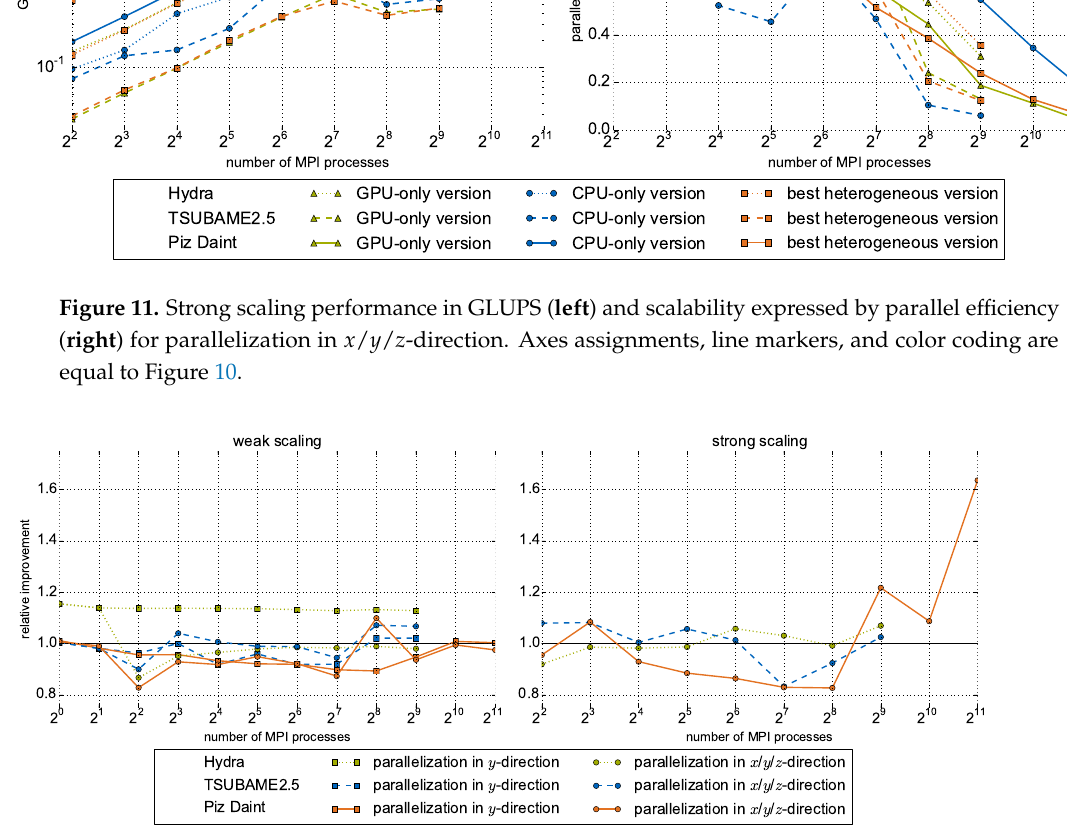
Figure 12. Factor of improvement (ordinates) of the heterogeneous version with the optimal CPU/GPU ratio in comparison to the heterogeneous GPU-only version in dependence of the degree of parallelism (abscissas). Weak scaling results (see Figure 10) are plotted on the left, strong scaling results (see Figure 11) on the right. Results for the three different CPU/GPU heterogeneous clusters are tinted in different colors, parallelization in different directions is distinguished by different line